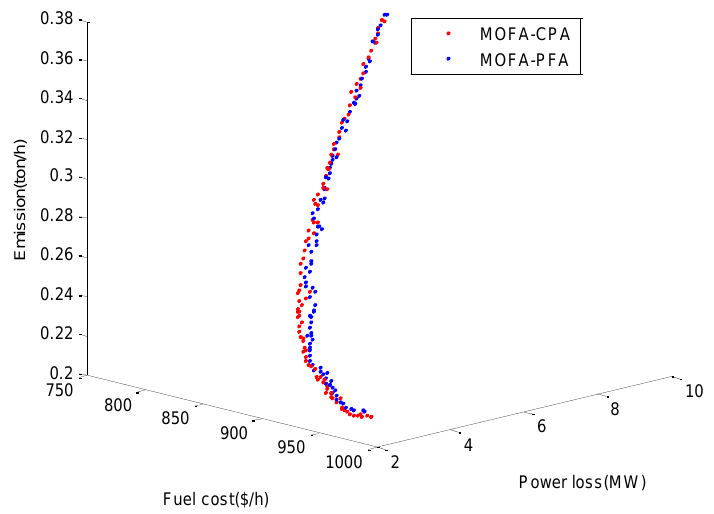
Figure 4. PFs obtained by MOFA-CPA and MOFA-PFA for Case 4.